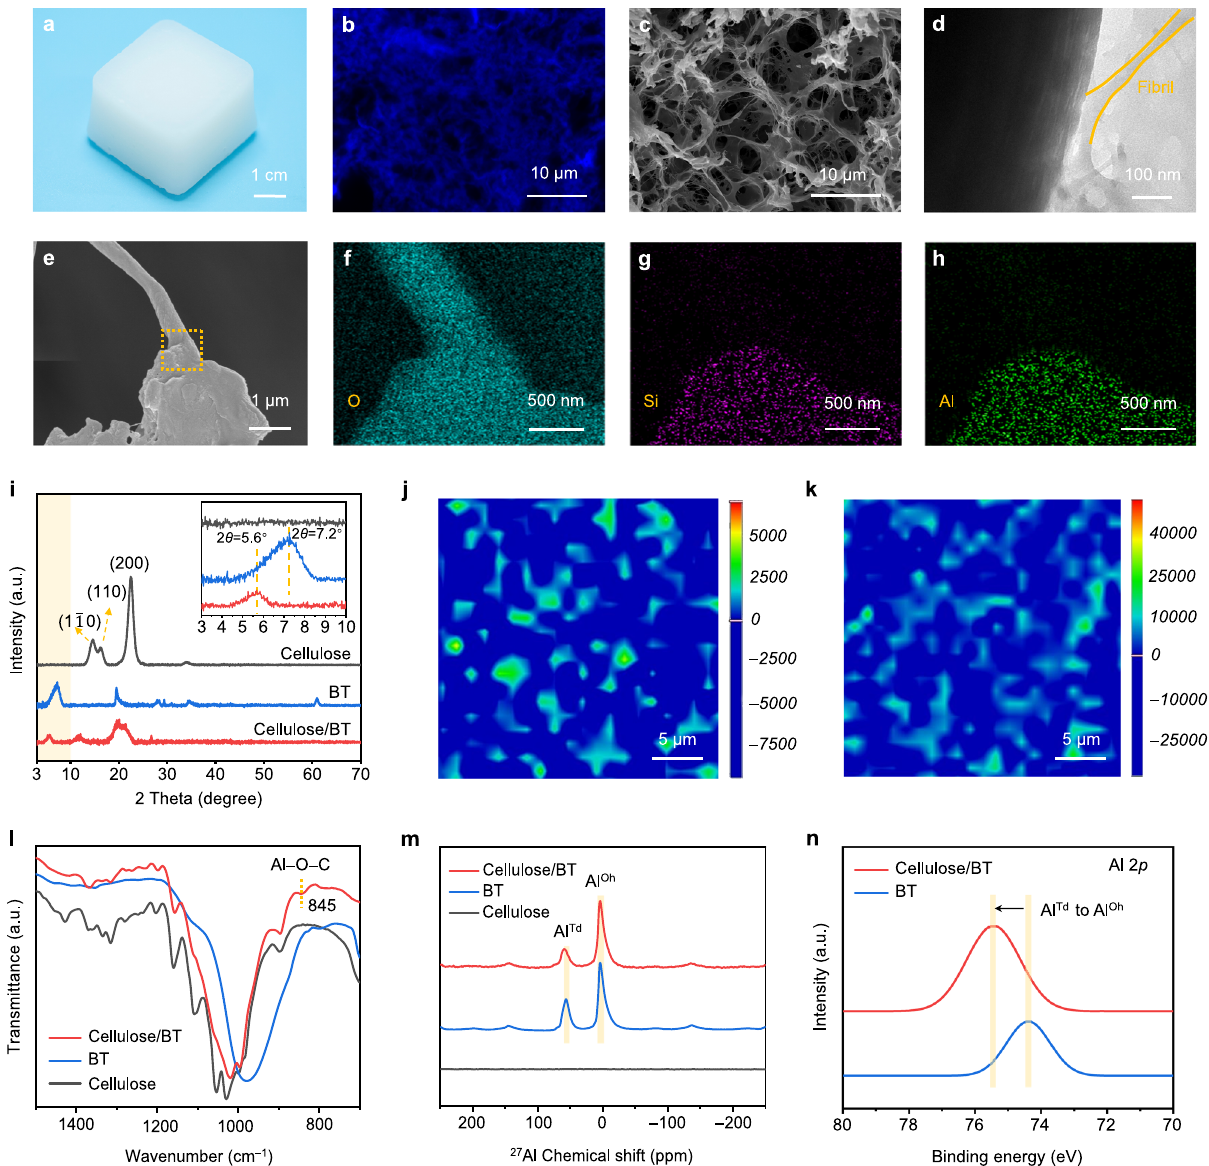
Fig. 2 Structure and morphology analysis of cellulose, BT, and cellulose/BT hydrogel. a Photograph of the Ion-CB hydrogel. b CLSM image of the Ion-CB hydrogel. c SEM image of the Ion-CB hydrogel shows the porous network. d TEM image of the mixture for cellulose and BT. e SEM image of the Ion-CB hydrogel under high magni fi cation to show interactions between cellulose and BT. f – h EDX mappings of O ( f ), Si ( g ), and Al ( h ) in the Ion-CB hydrogel. i XRD patterns of cellulose, BT, and Ion-CB hydrogel. The inset corresponds to their XRD patterns at 2 θ = 3° to 10°. j , k Two-dimensional (2D) Raman images of the Ion-CB hydrogel with BDE ( j ) and without BDE ( k ) obtained from the − OH stretching intensities (3000 – 3400 cm − 1 ). Blue corresponds to the chemically cross-linked domains, and green indicates the uncross-linked domains. l , m FTIR ( l ) and 27 Al solid-state MAS NMR spectra ( m ) of cellulose, BT, and Ion-CB hydrogels. n Al 2 p orbital XPS spectra of BT and Ion-CB